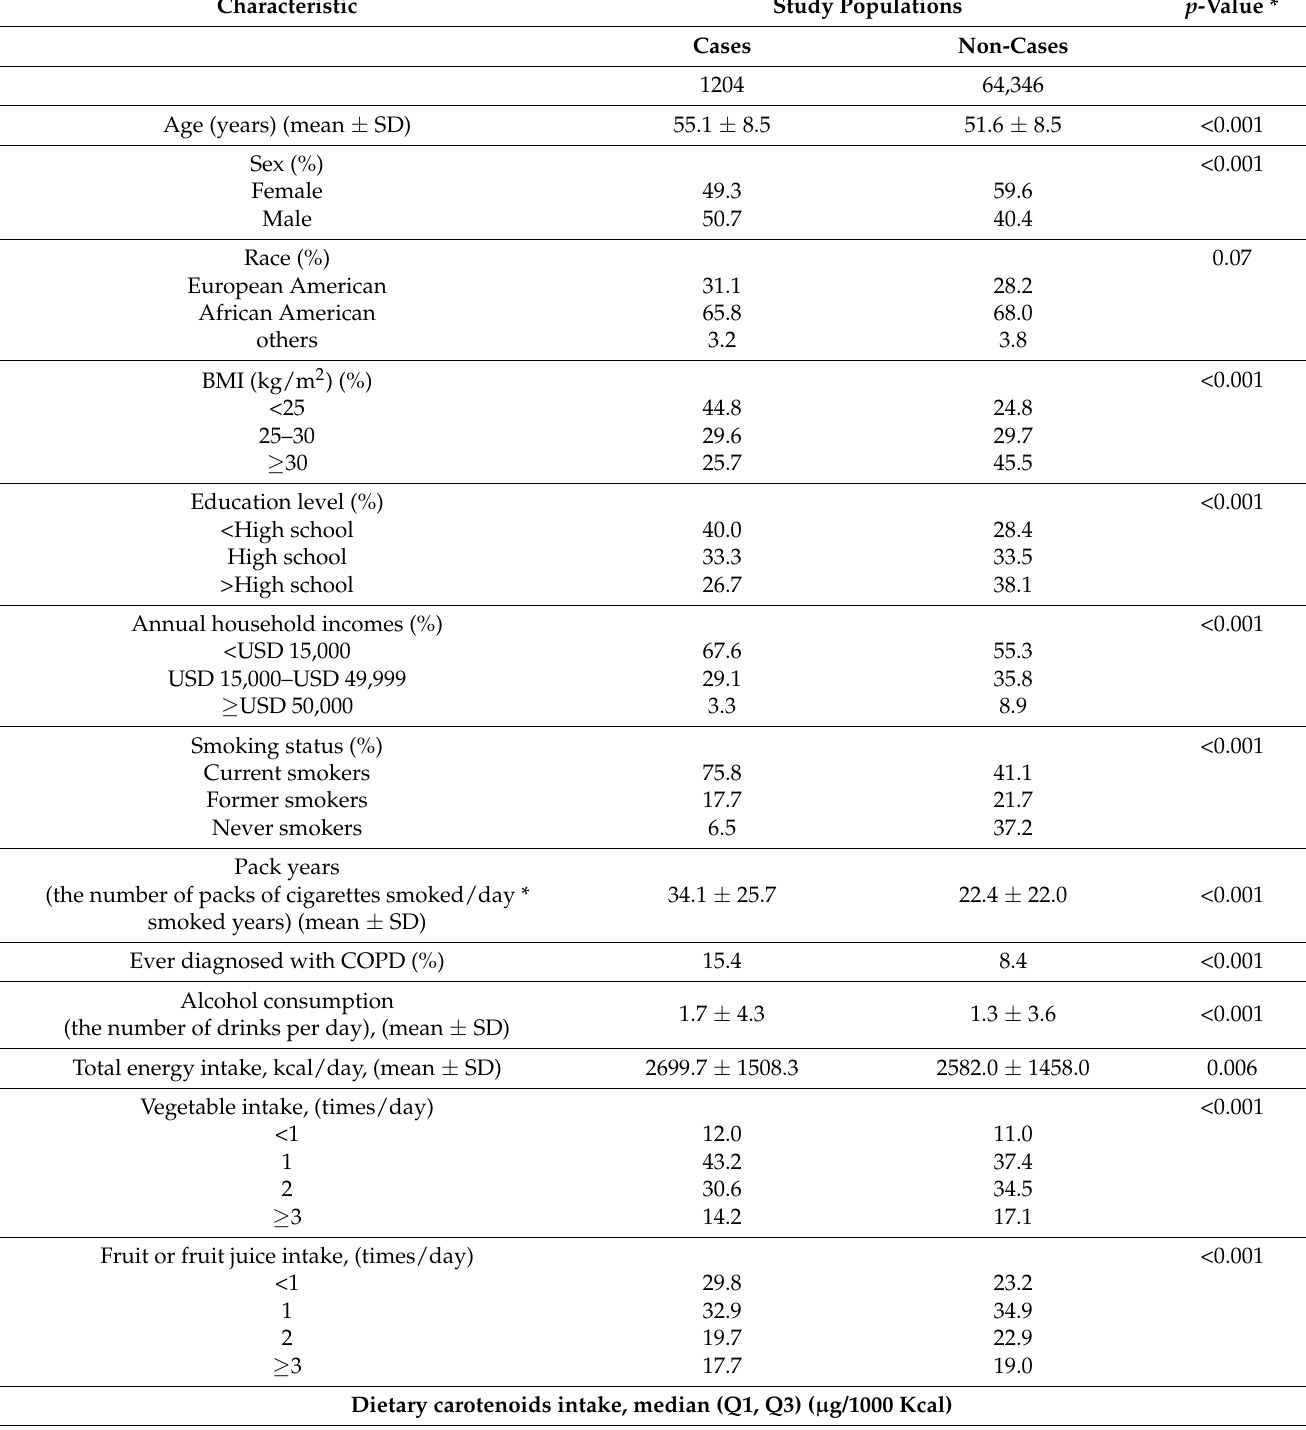
Table 1. Characteristics of study population and dietary intakes of carotenoids and vitamin A by lung cancer incident status,